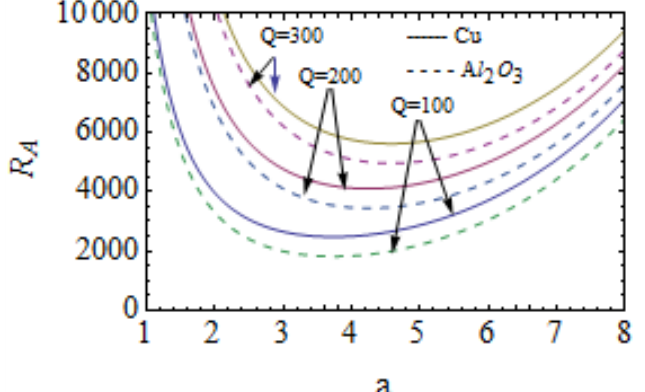
Figure 4. Impact of Chandrasekhar number